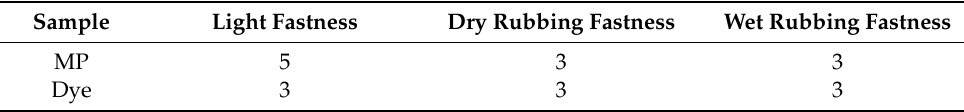
Figure 9. Fabric dyed with modified pigment without a light fastness test ( a ) and with a light fastness test ( b ); fabric dyed with acid dye without a light fastness test ( c ) and with a light fastness test ( d ). Table 3. Comparison of the fastness of modified pigment (MP) and Acid Blue 93 Dye.